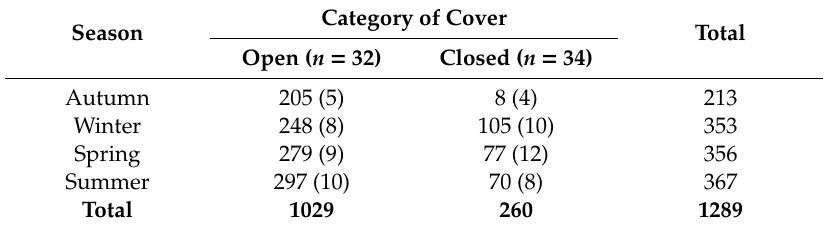
Table 2. Number of independent photographs of yellow mongooses in open and closed cover categories ( n = number of sites for each cover category) during different seasons in the Meyersdal estate.